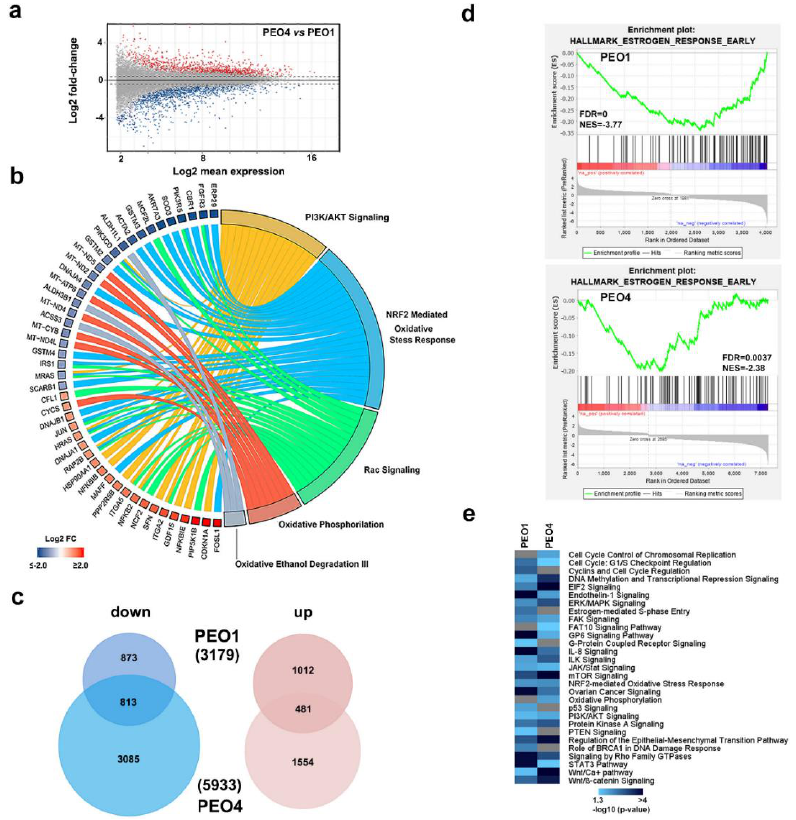
Figure 2. ERα expressing ovarian cancer cell characterization. ( a ) MA plot from RNA-Seq data showing transcriptome differences between PEO4 and PEO1 cells. Sequencing libraries were prepared from three independent biological replicates. ( b ) Circos plot showing transcripts over- (red) and under- (blue) expressed in PEO4 respect to PEO1 cells and influencing the indicated pathways. The length of the arks is proportional to the number of differentially expressed genes belonging to that pathway. Data derived from the list of statistically over-represented (p-value ≤ 0.01) pathways are selected based on differentially expressed genes (Log2 FC PEO4 vs. PEO1). ( c ) Venn diagrams showing the number of transcripts down- (light blue) or up- (pink) regulated by ICI (100 nM) in either PEO1 or PEO4 cells. 1.5 fold-change cut-off was selected as the threshold to identify differentially expressed genes. ( d ) Gene set enrichment analysis (GSEA) showing the Early Estrogen Response GO term highlighted by ICI-modulated genes in PEO1 and PEO4 cells. Negative Normalized Enrichment Score (NES) indicate that down-regulated genes are over-represented. ( e ) Statistically significant signaling pathways revealed by differentially expressed genes by ICI (100 nM) in PEO1 and PEO4 cells. Gray bars indicate a lack of statistically significant enrichment.